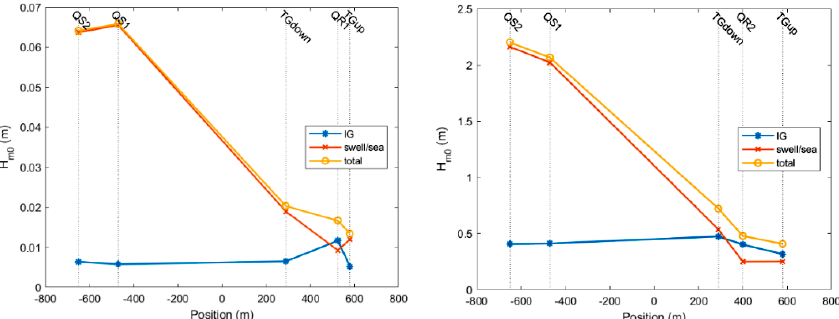
Figure 4. Evolution of the significant wave height, H m 0 , during both calm ( left ) and storm ( right ) conditions is shown with the total wave height ( o ) and the contributions from IG ( * ) and swell-sea ( x ).